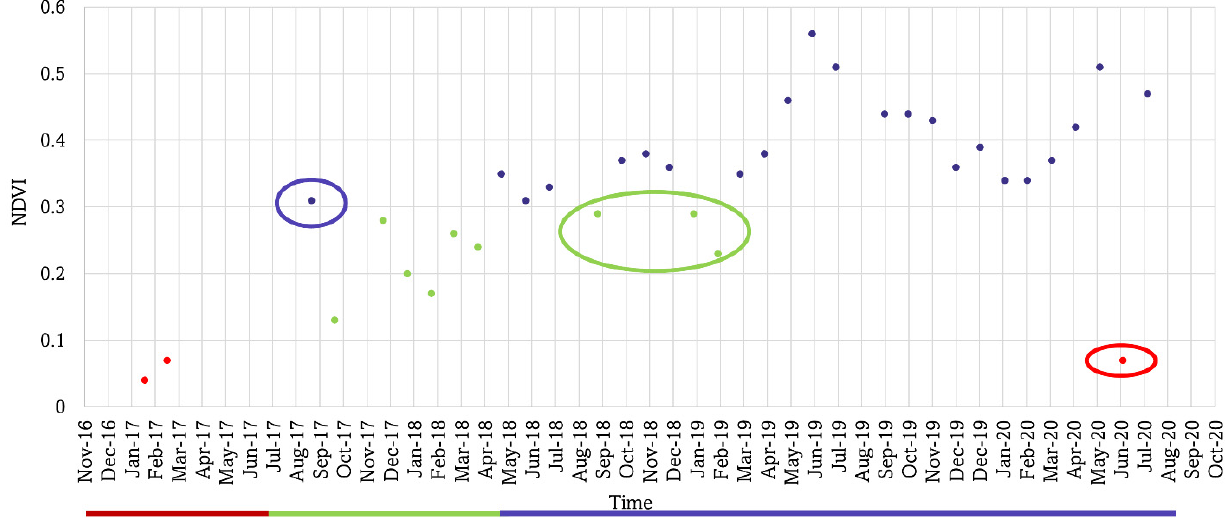
Figure 9. NDVI Time-Series Representative Plot ID87—Mangrove Stage Changes Using Rule-based Methodology Degradation to Recovery; The Circled Showed Some NDVI of Each Mangrove Stage Did Not Follow NDVI Rule-Based on Time-series Data.